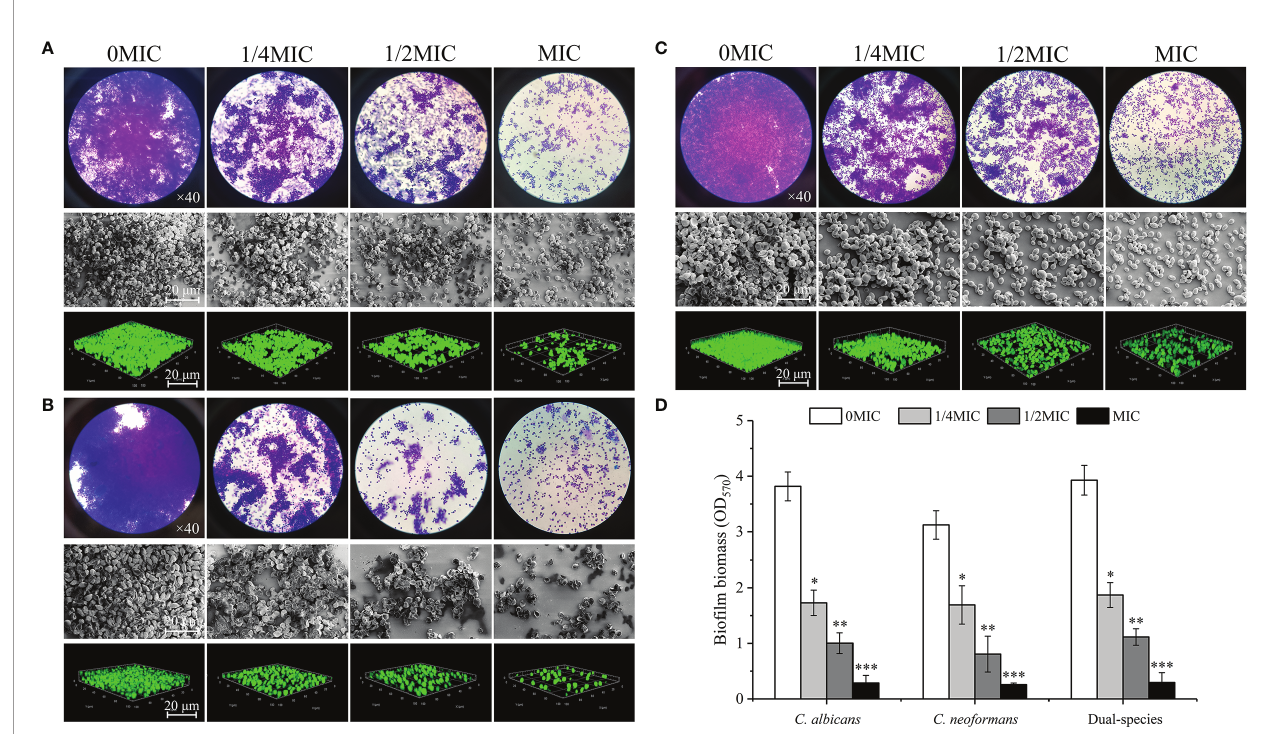
FIGURE 5 | Examination of effects of paeonol on the bio fi lm formation of C. albicans SC5314 (A) , C. neoformans H99 (B) , and dual-species (C) with both qualitative and quantitative approaches. (A – C) Qualitative analysis of bio fi lm formation was examined at fi nal concentrations of paeonol ranging from 0 to MIC using the light microscope (objective lens, ×40), fi eld emission scanning electron microscope (FESEM), and confocal laser scanning microscope (CLSM). (D) Inhibitory effects of paeonol on bio fi lm formation were assessed quantitatively using the crystal violet staining assay. Scale bars represent 20 m m for FESEM and CLSM. Bars represent the standard deviation ( n = 3). * p < 0.05; ** p < 0.01; *** p <